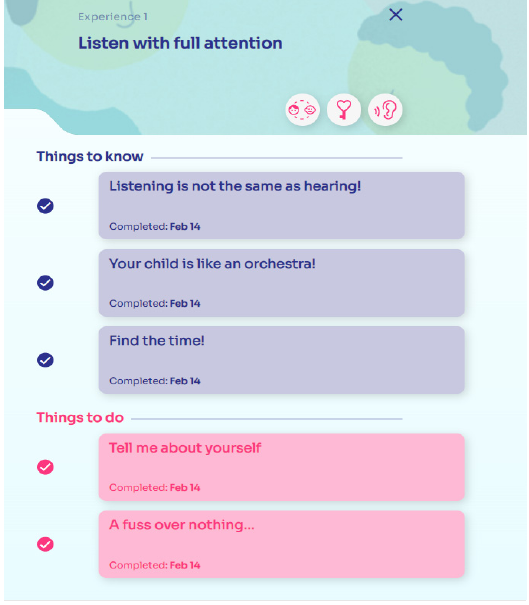
Figure 3. MinUTo app, examples of the sections “Things to know” and “Things to do” for the Experience “Listening with full attention”.